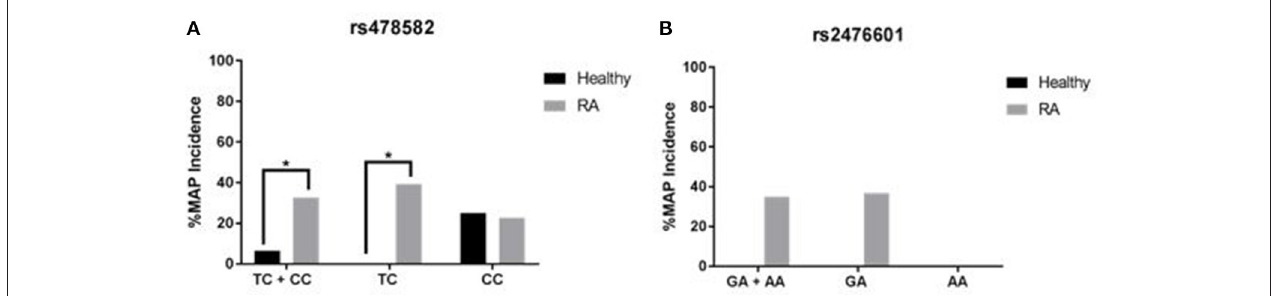
FIGURE 6 | Effect of PTPN2:rs478582 and PTPN22:rs2476601 on Susceptibility to MAP Infection. (A) MAP in the blood from RA and healthy samples associated with PTPN2:rs478582 [heterozygous allele (TC), minor allele (CC) and combined alleles (TC + CC)]. (B) MAP in the blood from RA and healthy samples-associated with PTPN22:s2476601 [heterozygous allele (GA), minor allele (AA), and combined alleles (GA + AA)]. * P -values ≤ 0.05.